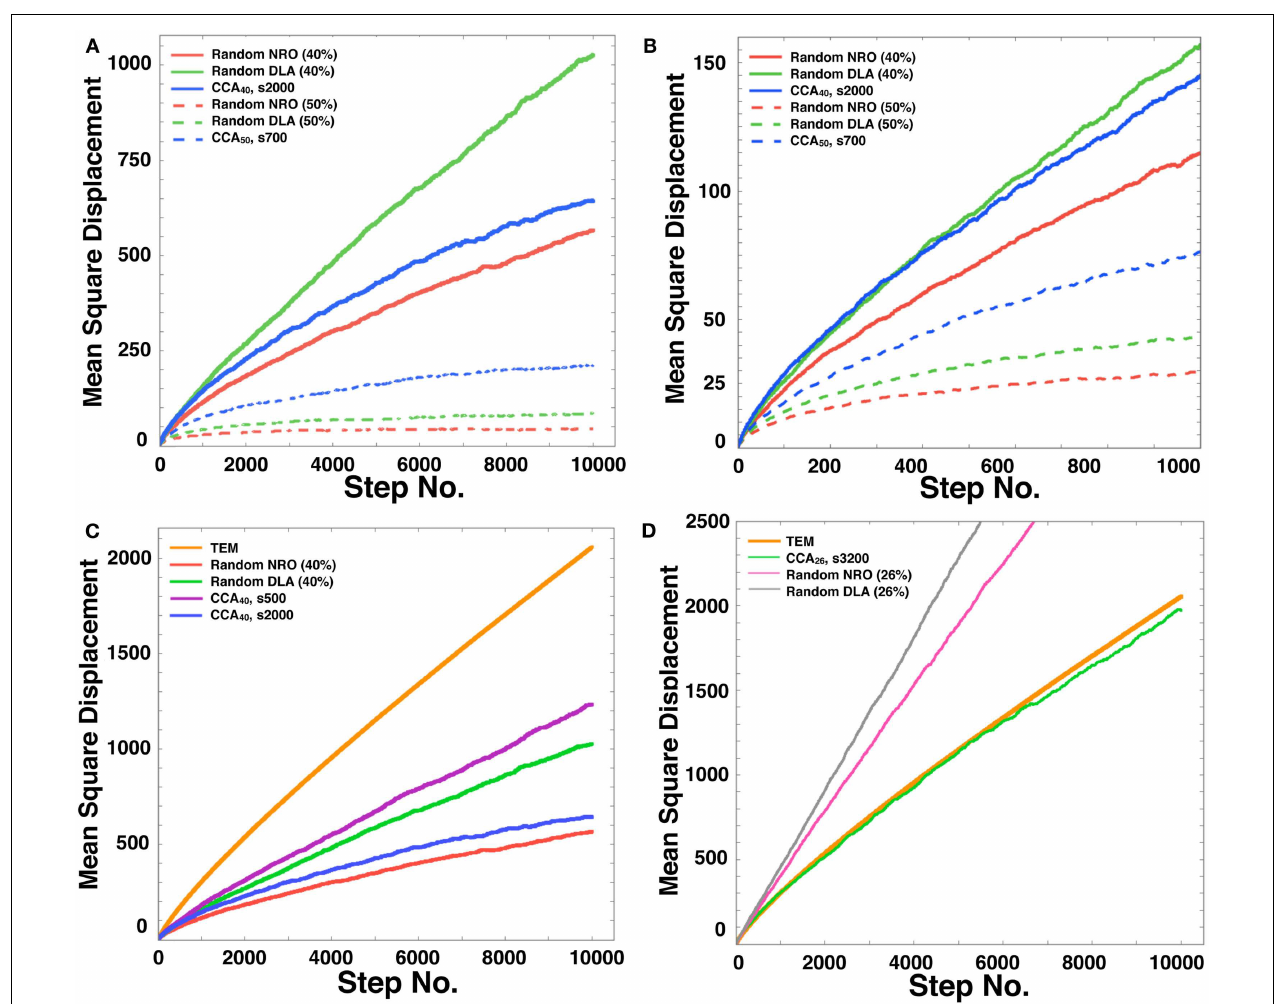
with 50% of NRO, dashed red line; random DLA with 50% of NRO, dashed green line; CCA with 50% of NRO at the 2,000th step, dashed blue line). (C) Mean square displacement of a mobile particle diffusion in each model space during a long simulation time up to the 10,000th step (TEM image, orange line; random NRO with 40% of NRO, red line; random DLA with 40% of NRO, green line; CCA with 40% of NRO at the 2,000th step, blue line; CCA with 40% of NRO at the 500th step, purple line). (D) Mean square displacement of a mobile particle diffusion in each model space during a long simulation time up to the 10,000th step (TEM image, bold orange line; random NRO with 26% of NRO, fine magenta line; random DLA with 26% of NRO, fine gray line; CCA with 26% of NRO at the 3,200th step, fine green